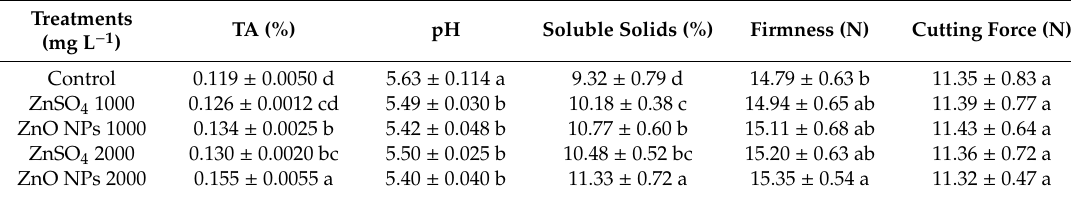
E ff ect of foliar application of ZnO NPs and ZnSO 4 on fruit development and biomass